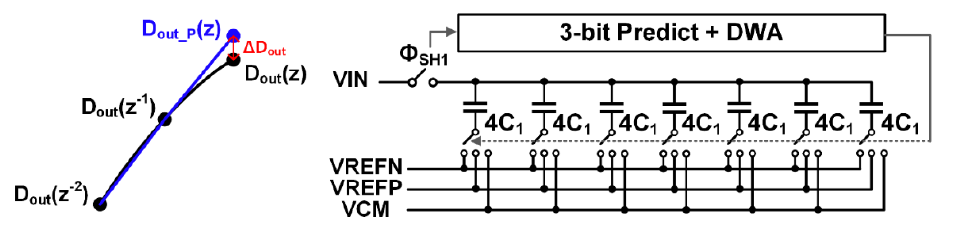
Figure 8. ( left ) Second-order prediction algorithm; ( right ) CDAC configuration for 3-bit DWA ap- plication.